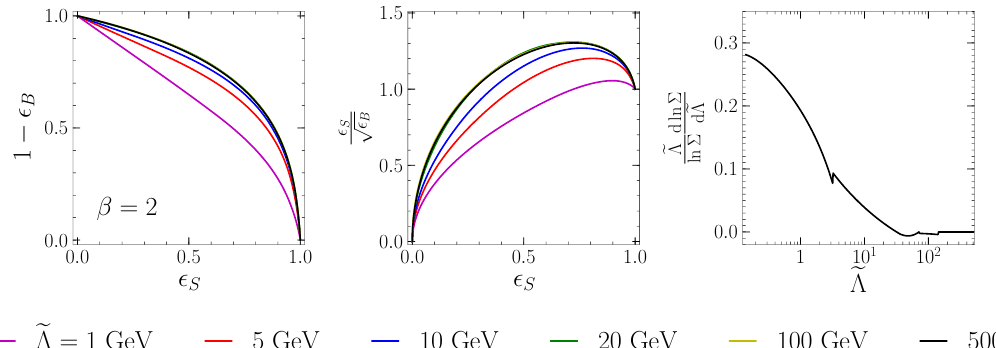
Figure 4 . Discrimination of dark sector against QCD for various choices of the confinement scale e (cid:3) for p T = 1 TeV jets, using the MLL analytic calculation. Note that the impact of errors is ignored here, see section 2.4 for details. We show ROC curves in the background rejection 1 signal efficiency (cid:15) S plane [left]. We show the curve of discriminatory significance (cid:15) S = p (cid:15) B against signal efficiency (cid:15) S [middle]. Fixing the background rejection at 90 % , we then show the relative change in discriminatory power as a function of e (cid:3) . The angular dependence parameter is (cid:12) = 2 for all